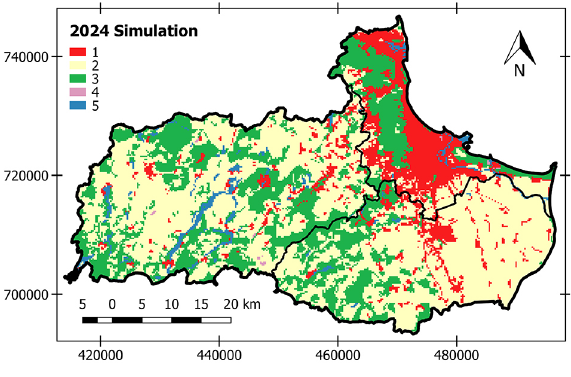
Fig. 7. Predicted land use in